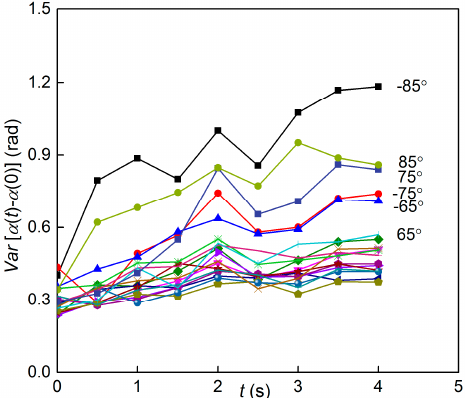
Figure 15. Variance of the turning amplitude at different time for various angles α (0). Water 2018 , 10 , x FOR PEER REVIEW